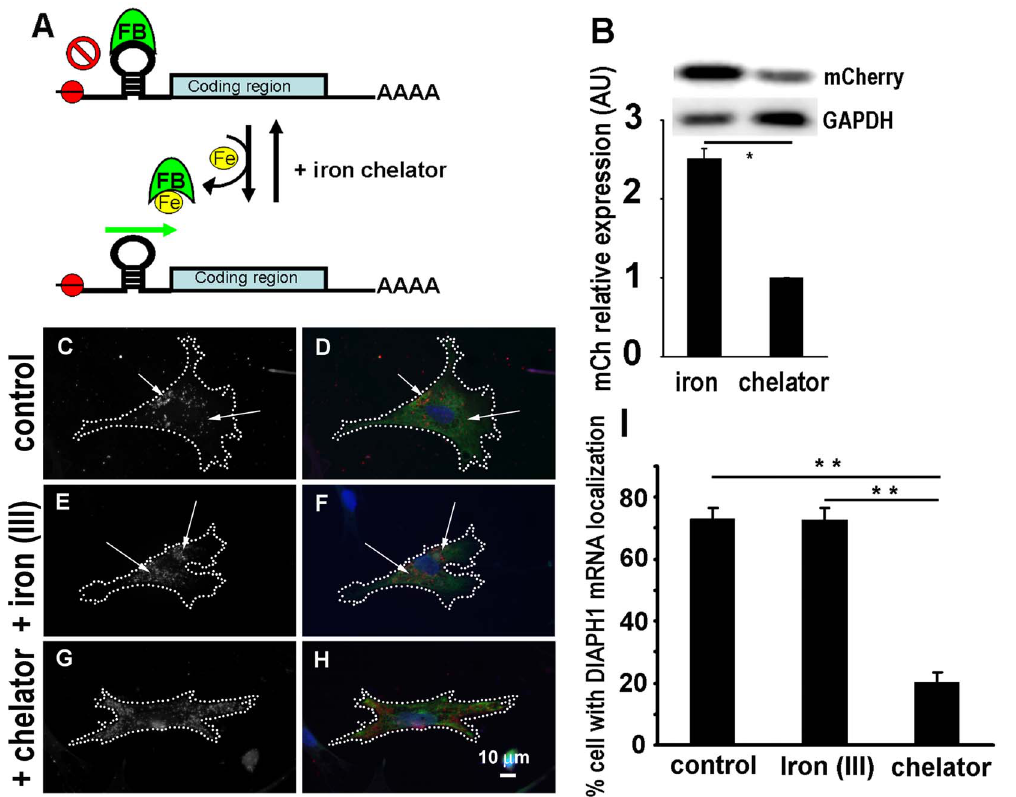
Figure 3. Manipulation of DIAPH1 mRNA localization using an Iron ribo-switch. A . Schematic diagram of the IRE riboswitch (See Materials and Methods for details). Red balls represent 5 9 -cap. FB: iron biding protein which also binds to the IRE stem-loop. Green arrow indicates translation permission. B . Western blotting result of mCherry reporter for the effect of IRE in fibroblasts. A construct consisting of IRE-mCherry was transfected into CEF. 3 hr post transfection, ferric ammonium citrate (final 100 m M) or iron chelator desferrioxamine mesylate (final 100 m M) was added into the growth medium. 16 hr after transfection, the cells were collected for Western blotting. Quantitative results of Western blotting (n=4), * p , 0.05. C–H . IRE-mediated control of DIAPH1 mRNA localization. CEF were transfected with a construct consisting of IRE - DIAPH1 and then treated similarly as in B . 16 hr after transfection, the cells were fixed and processed for FISH detection of mRNA localization. C–H . Representative cells. Red: DIAPH1 mRNA signal; Green: HA-tagged DIAPH1 protein signal; Blue: nucleus. C , E & G are gray scale images for better presentation of DIAPH1 mRNA in the cells. Dotted lines show cell border. Arrows indicate localizing DIAPH1 mRNA. I . Quantitative results of DIAPH1 mRNA localization from analysis of 300–500 cells from three independent experiments for each condition. Error bars: sem. ** p , 0.01.